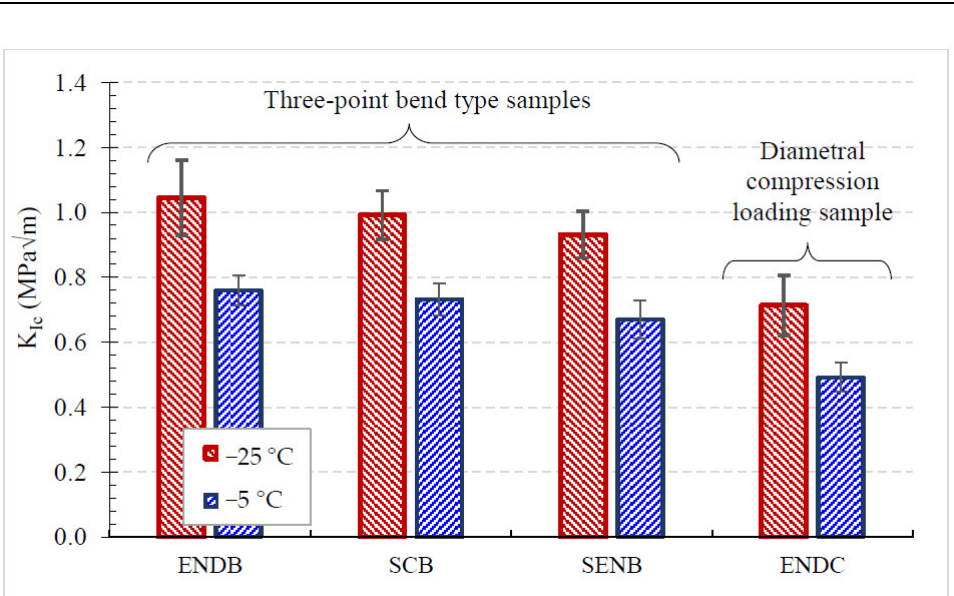
Figure 10. Comparison of fracture toughness data obtained from different mode I testing methods.